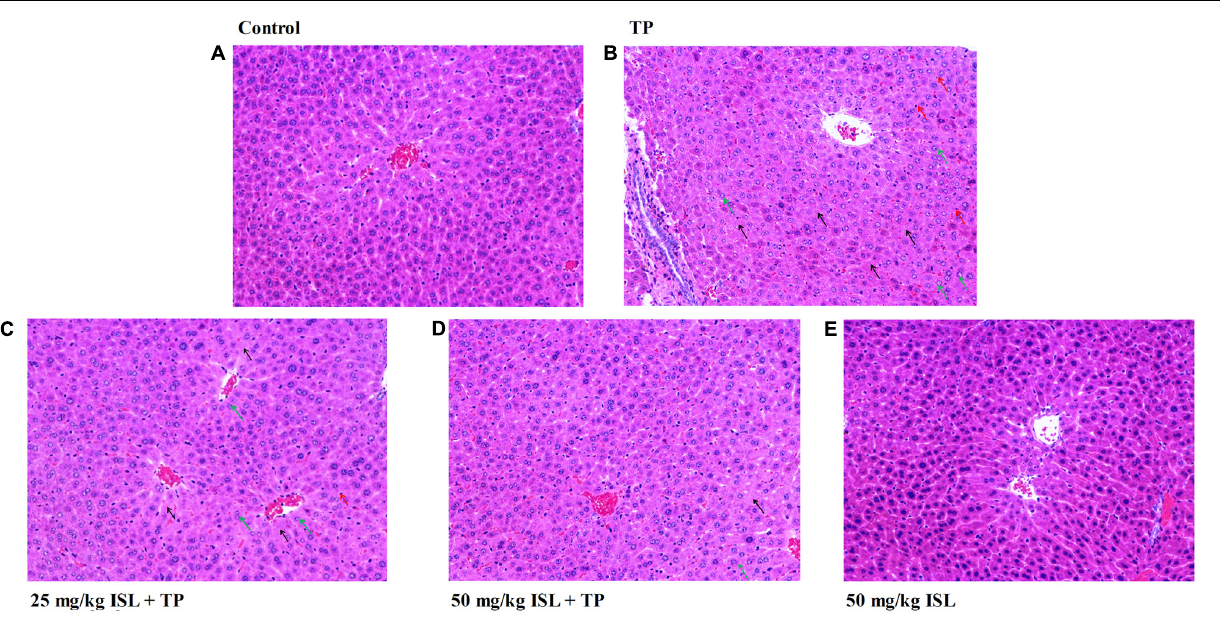
FIGURE 4 | Photomicrographs ( × 200) of hematoxylin & eosin-stained liver sections obtained from the (A) control, (B) TP (1.0 mg/kg), (C) ISL (25 mg/kg) + TP (1.0 mg/kg), (D) ISL (50 mg/kg) + TP (1.0 mg/kg), and (E) ISL (50 mg/kg) groups. Green arrows indicate hepatocellular hydropic degeneration, black arrows indicate necrosis, and red arrows indicate inflammatory cell